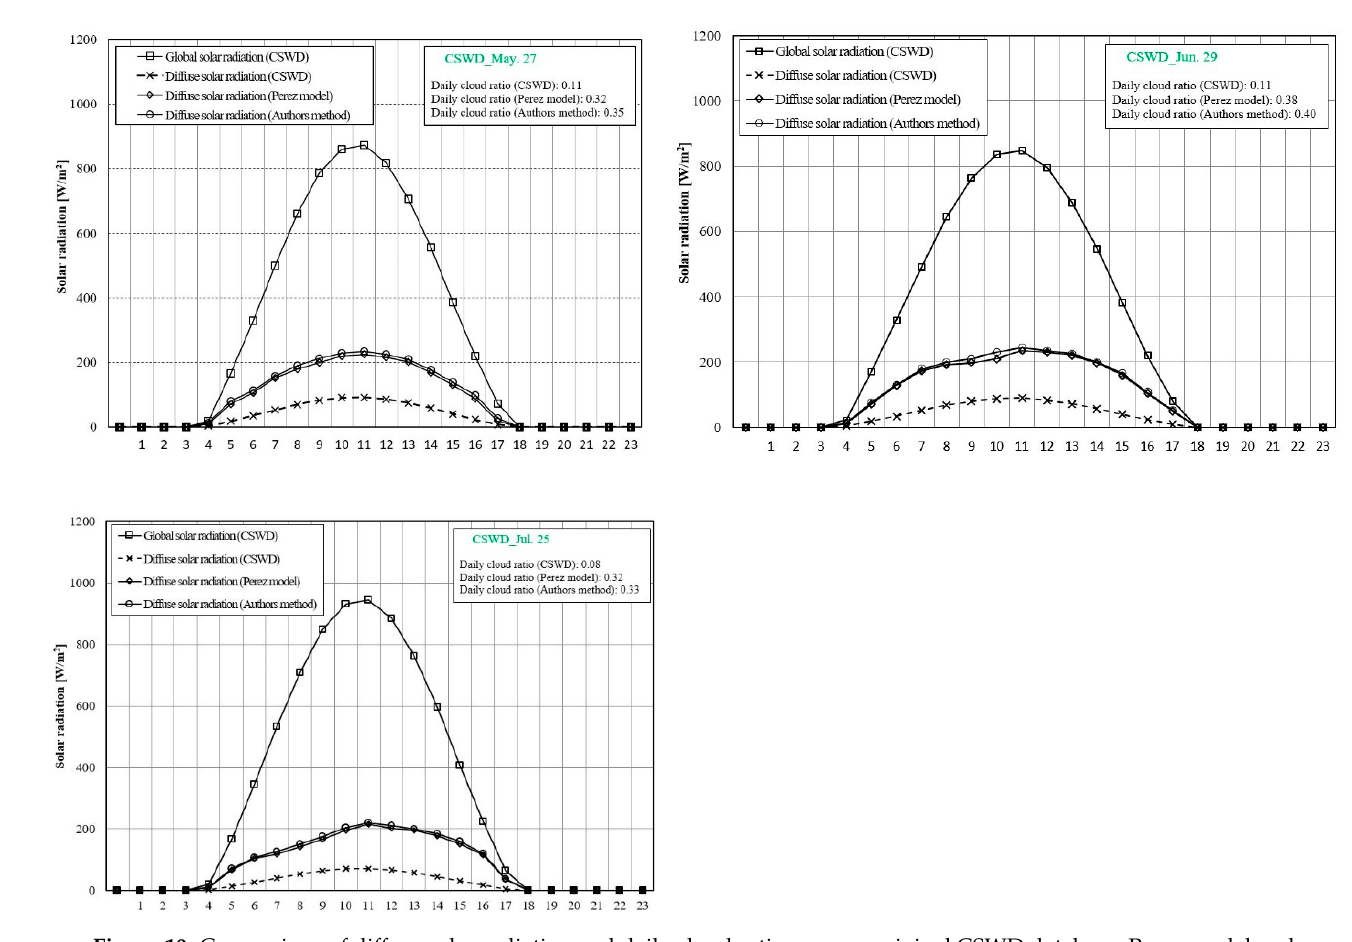
Figure 10. Comparison of diffuse solar radiation and daily cloud ratios among original CSWD database, Perez model and authors’ simple refinement method in Shanghai, China.